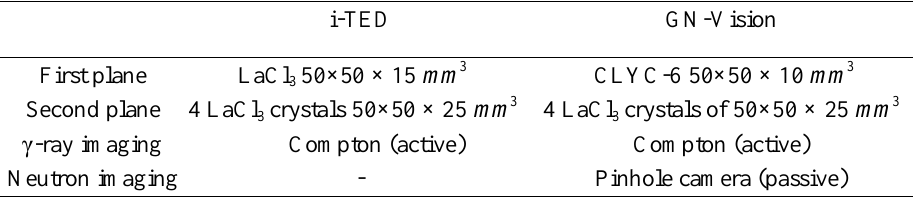
Table 1. Summary of the main components and imaging techniques used in i-TED detector and its evolution